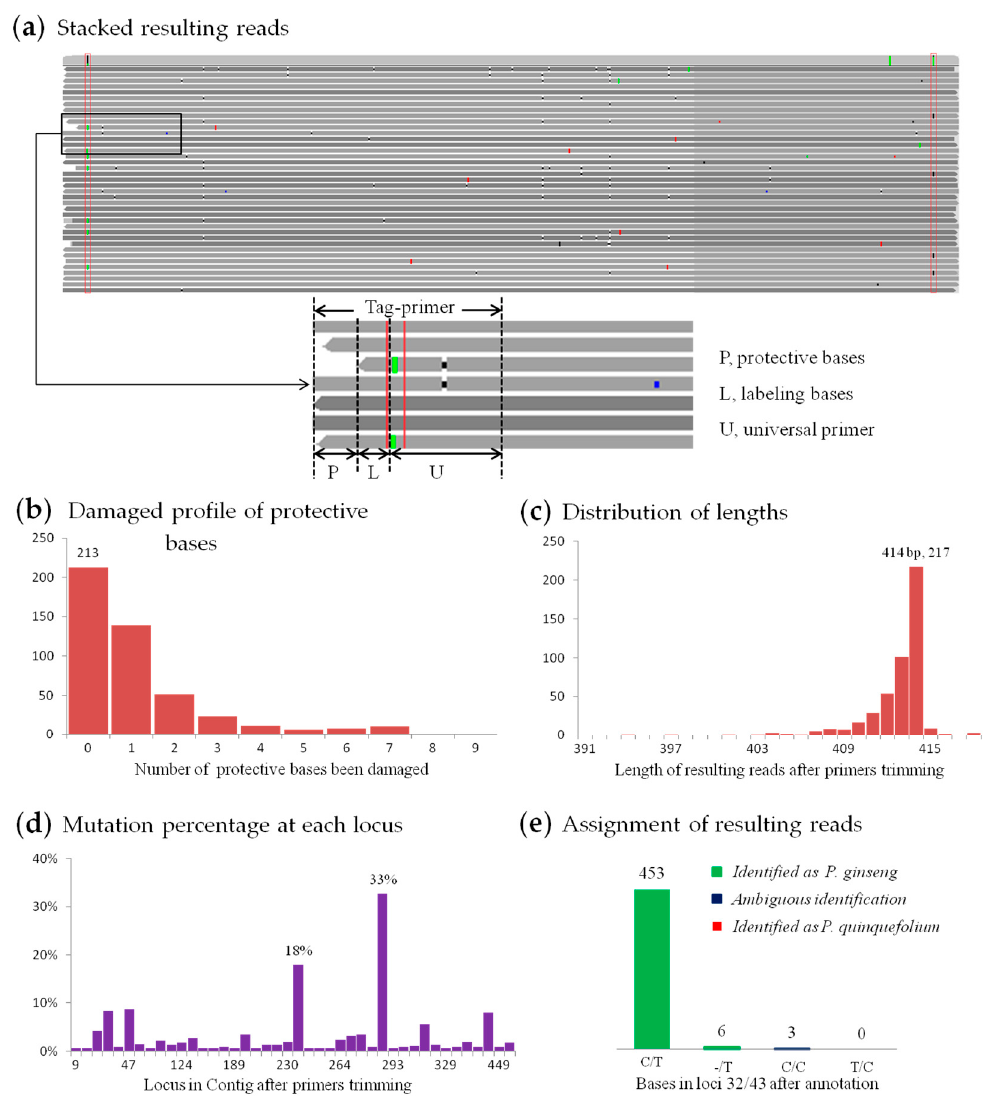
Figure 5. Analysis of 462 resulting reads from the ITS2 (the second internal transcribed spacer of nuclear ribosomal DNA) amplicon of RS3. ( a ) Part of stacked resulting reads; red boxes mark degenerate bases in tag-primers whose constitution shows in the smaller block below. ( b ) Damaged profile of protective bases, as the bases missing at both ends in ( a ). ( c ) Length distribution after primers trimming. ( d ) Mutation percentage at each loci (only shows those with percentage higher than 0.5%). ( e ) Species assignment results.